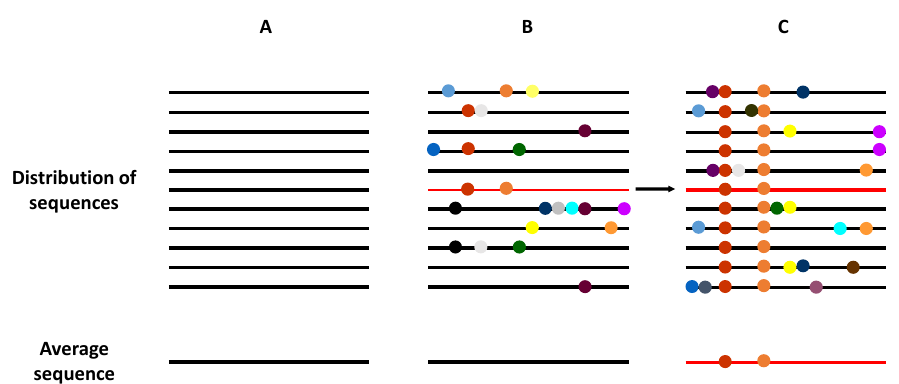
Figure 2. Schematic representation of the genome composition of a virus population. Viral genomes are represented as horizontal lines, and mutations as symbols in the lines. ( A ) A homogeneous virus population in which no mutations are generated, such that all genomes within this population are identical. ( B ) A heterogeneous virus population in which mutants are generated at a high frequency, such that most of the genomes are genetically different. However, the average consensus sequence of this population is identical to in the homogeneous population ( A ). ( C ) The selection of an individual genome (marked in red), via random drift or positive selection, generates a new distribution of variants if the replication system produces new mutations. Now, the average population genome sequence is different from that shown in panels ( A , B ).